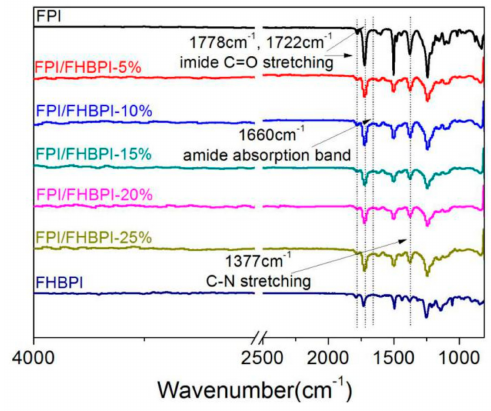
Figure 1. FTIR spectra of FPI, FPI / FHBPI composites and